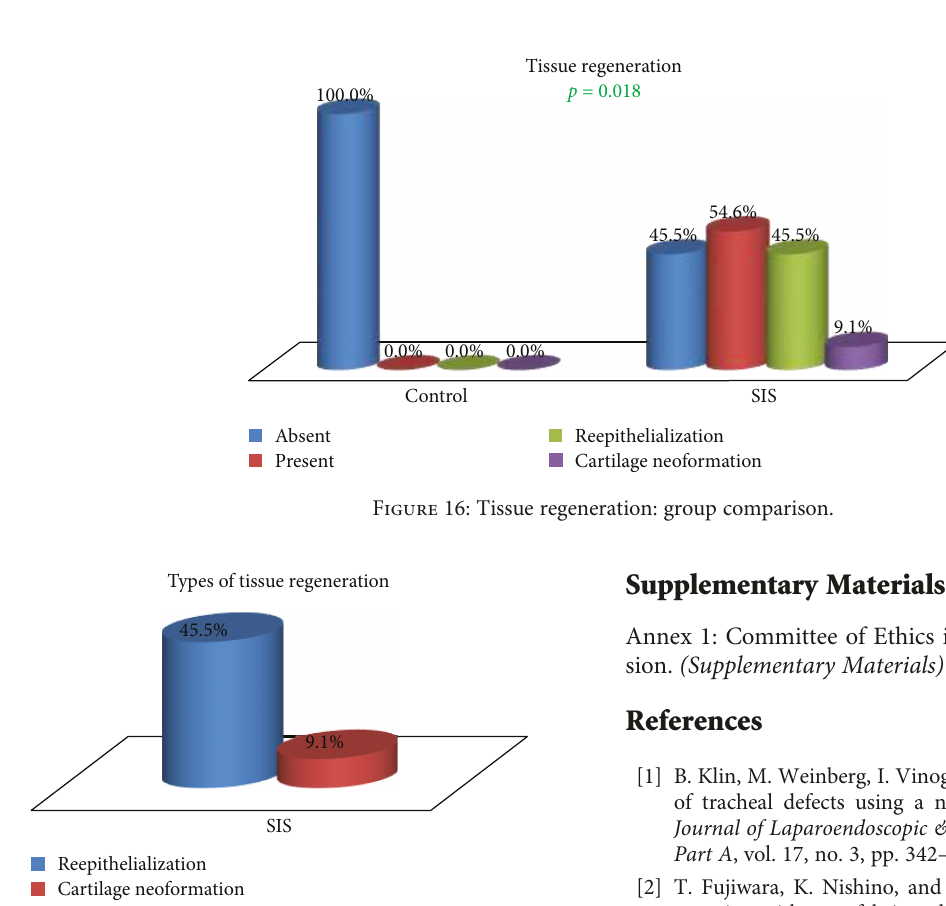
Figure 17: Tissue regeneration type within the SIS